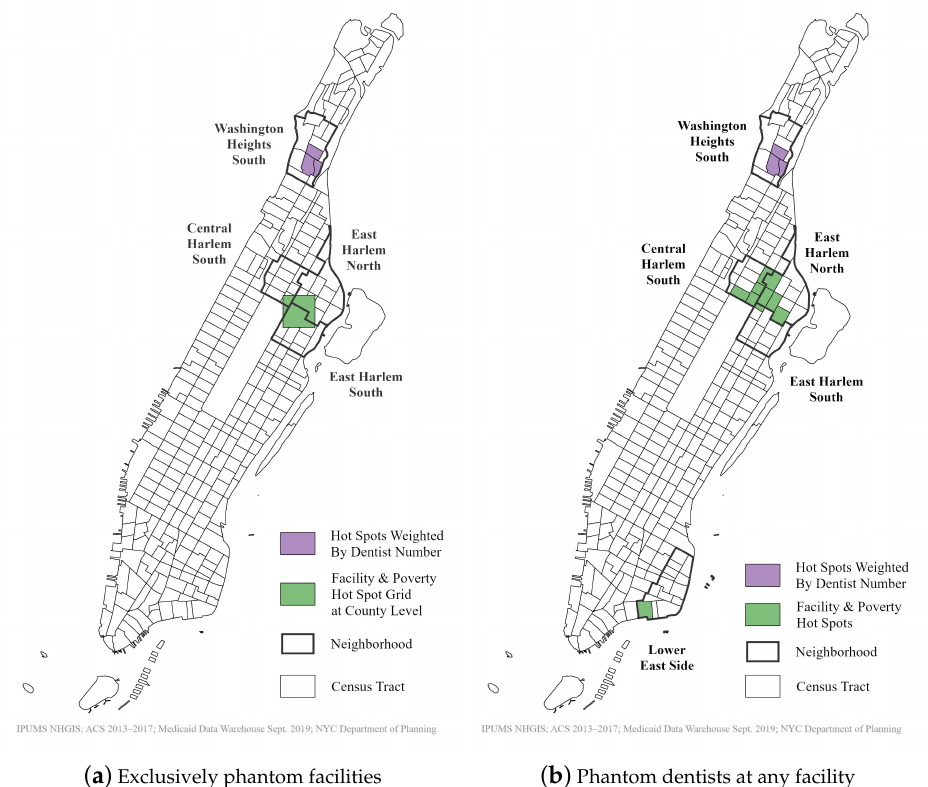
Figure 3. Optimized hot spots of phantom networks and poverty, October